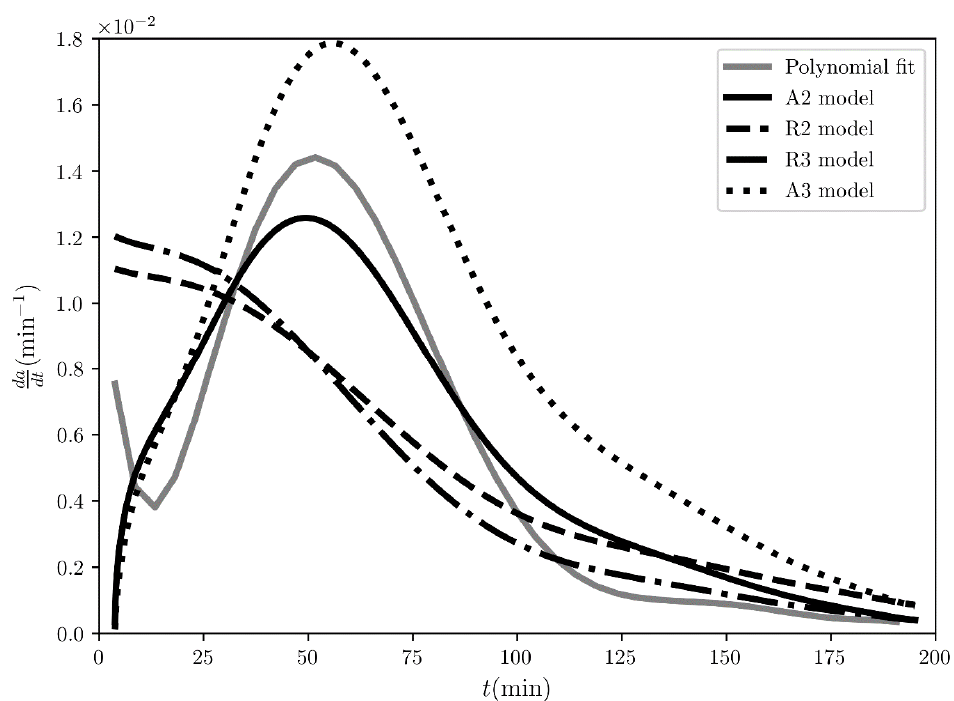
Figure 3. The reaction speed time evolution regarding the desolvation of the sulfameter solvate at 47.19 °C. The solid grey line represents the rate evaluated from the initial polynomial that fits the experimental conversion fraction measured by A. Khawam and D. Flanagan [4], while the solid and dashed black lines represent the fitting curves for the “best” four models ranked by COMF, i.e., A2, R2, R3 and A3 models.